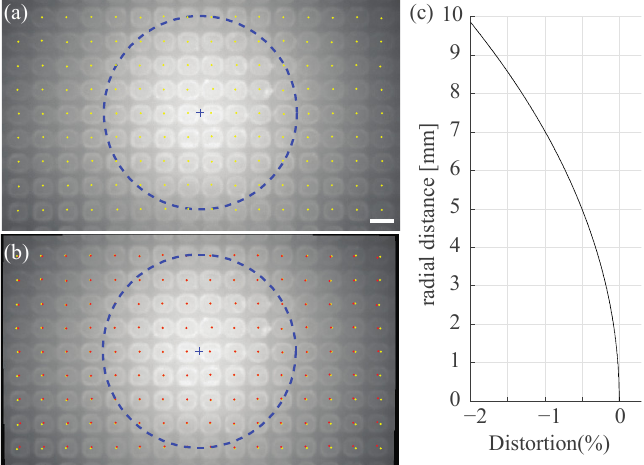
Figure 4. Image Distortion. ( a ) The original image of the 1 mm spaced pattern. Yellow dots are the centers of each object. The scale bar is 1 mm. ( b ) Undistorted images from the image in ( a ). The red and yellow dots are the centers of each object in the undistorted images and the original images, respectively. The radius of the blue dotted circle in ( a ) and ( b ) is 4 mm. ( c ) The measured distortion rate of the imaging system.